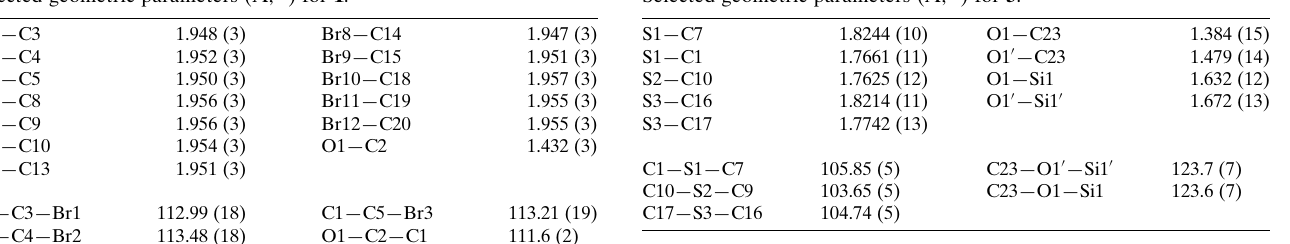
Table 2 Selected geometric parameters (A˚ , (cid:2) ) for 3 .